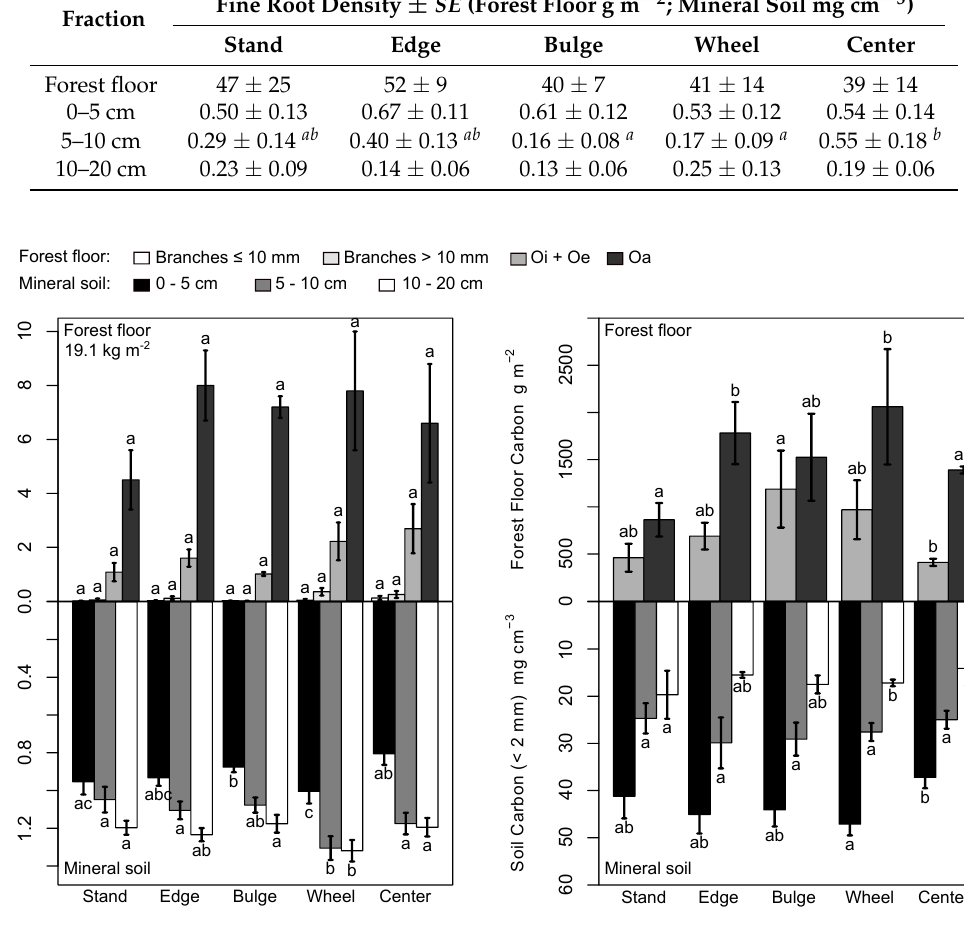
Figure 4. Forest floor and mineral soil bulk mass/density and carbon stocks by fraction and stratum in 2015. The entire biomass after deposition (deposited stock plus mean stand stock) is listed in the upper left. Letters indicate significant differences between strata for the individual fraction or depth (Dunn’s test, p < 0.05). Bars are one standard error of